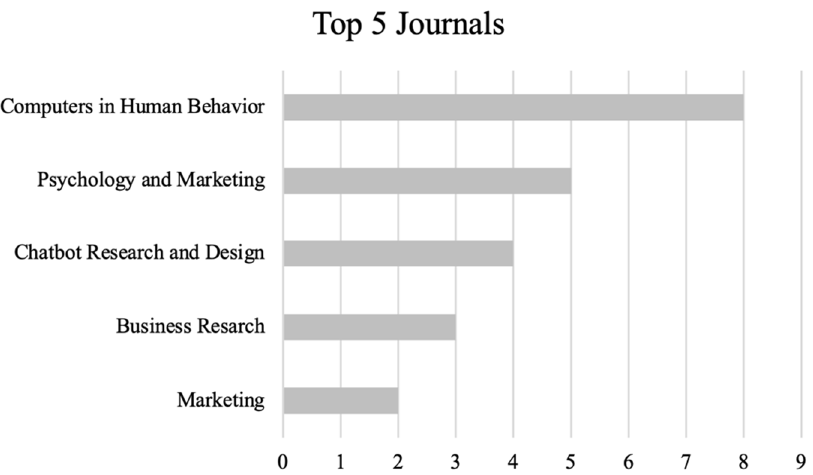
Figure 6 . Visualization of the top 5 used